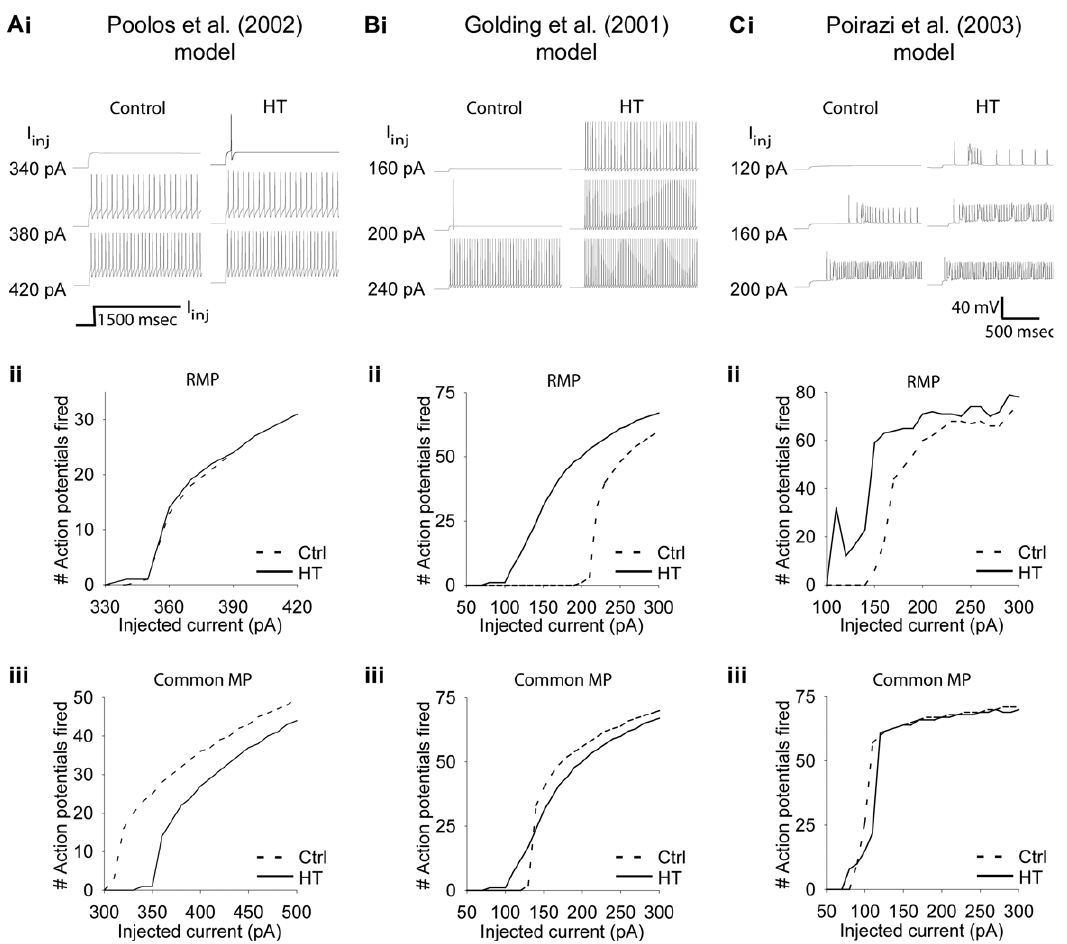
Figure 3. Altered h-current causes hyperexcitability in three detailed CA1 pyramidal neuron models. (Ai, Bi, Ci) Example traces of response to 1500 ms simulated apical dendritic current injections with control (left) and HT (right) h-current parameters. Note that HT models always fi re at lower current injection amplitudes than controls. (Aii, Bii, Cii) Number of action potentials fi red in response to 1500 ms simulated dendritic current injections in control (dashed line) and HT (solid line) model cells, from their respective RMPs. (Aiii, Biii, Ciii) Number of action potentials fi red in response to 1500 ms simulated apical dendritic current injections in control (dashed line) and HT (solid line) model cells, from a common holding potential. Note that due to specifi c model parameters, the common holding potential varied between